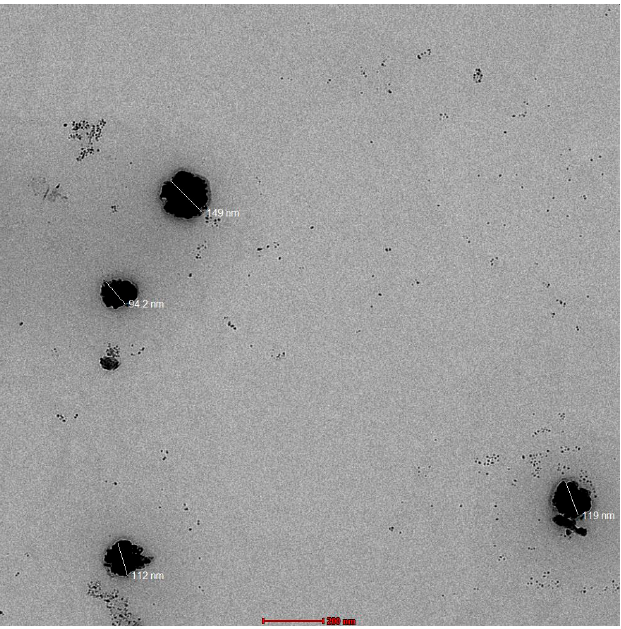
Figure 3. Morphology of TES .